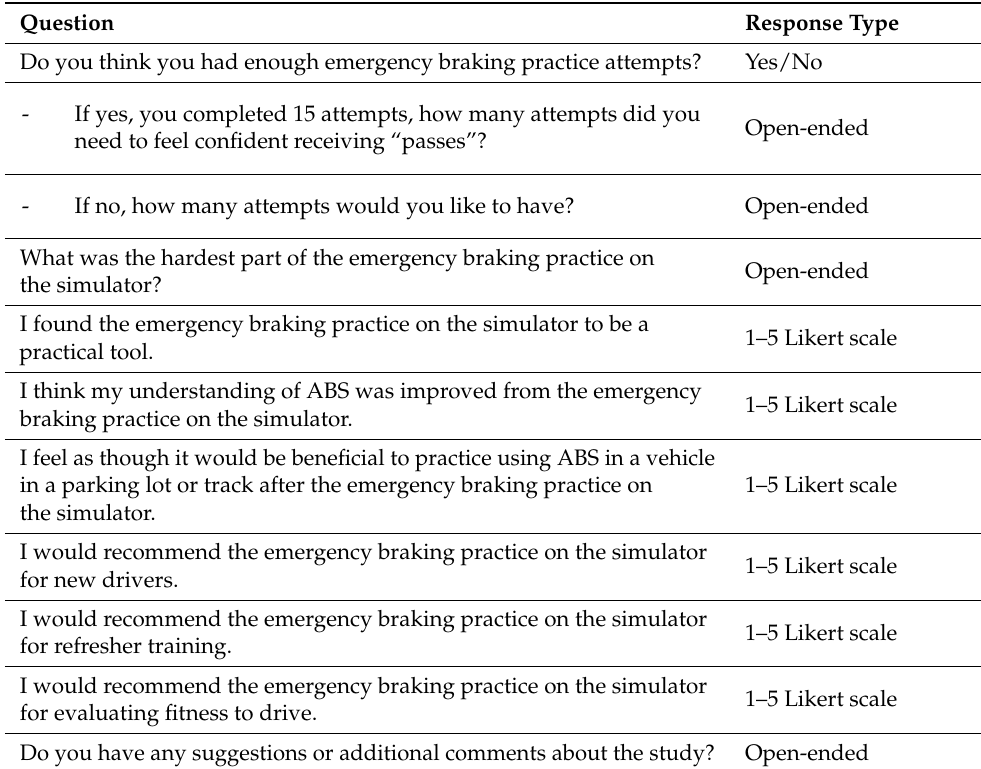
Table 2. Survey questions and response